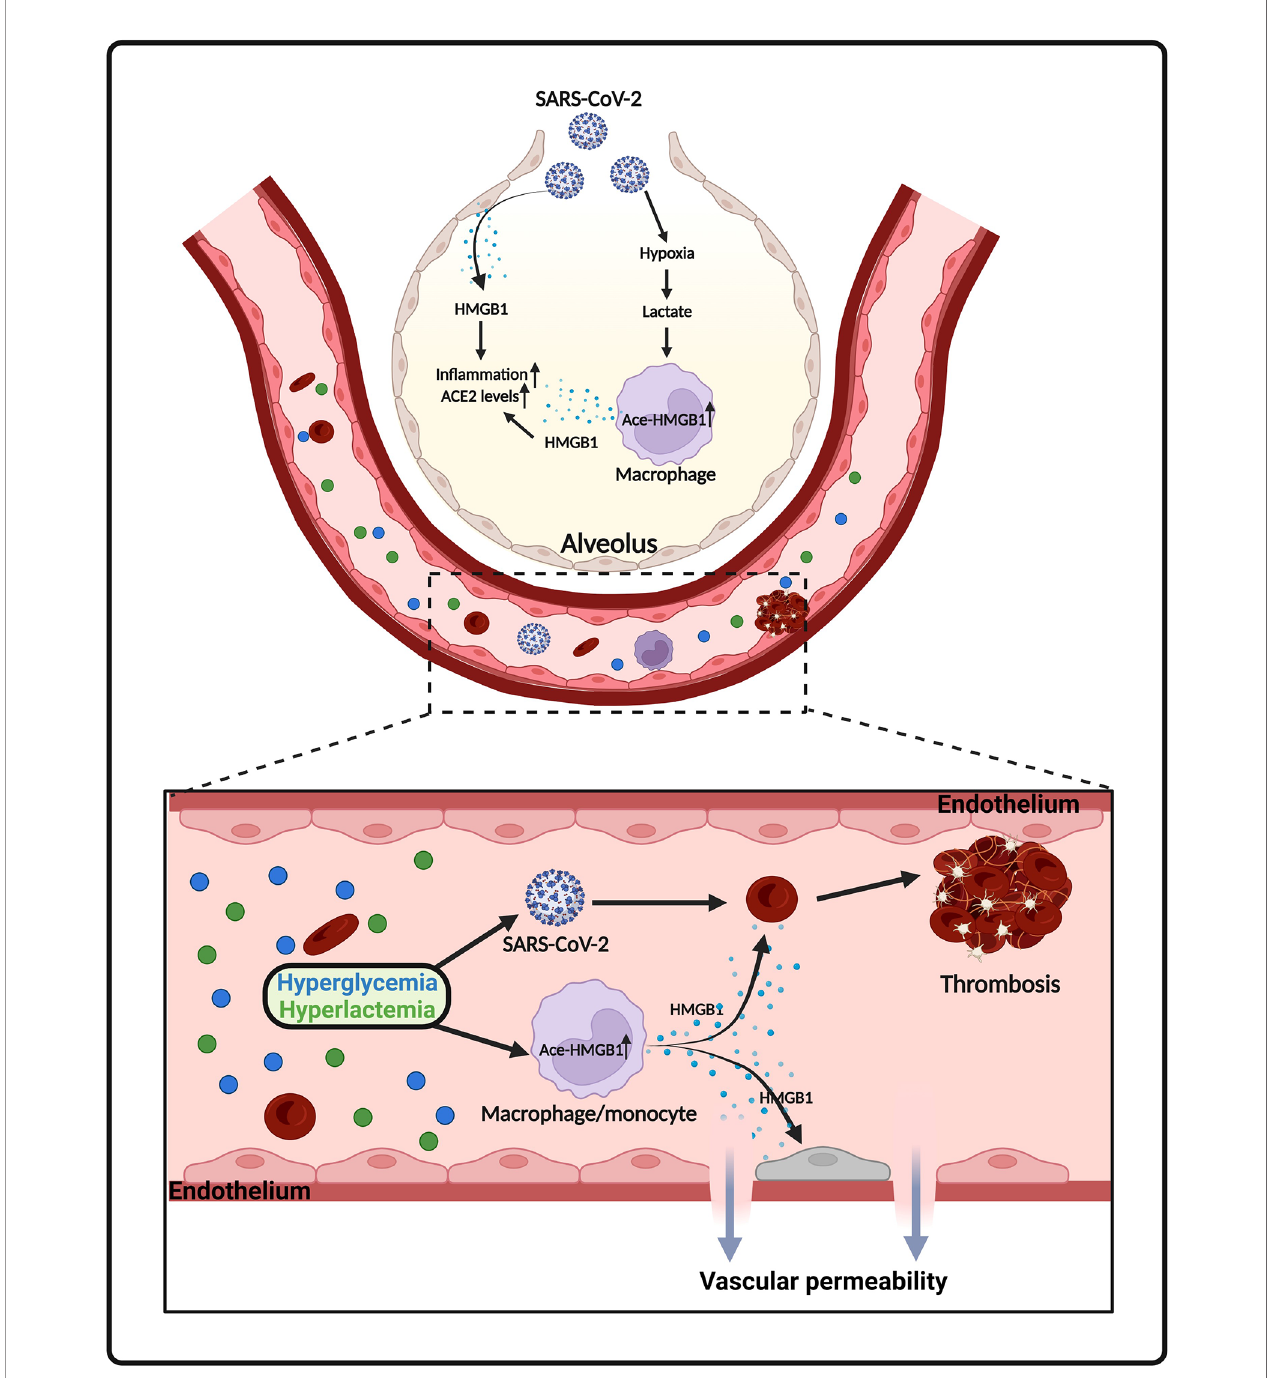
FIGURE 4 | Proposed model of HMGB1 release in SARS-CoV-2 infection. SARS-CoV-2 infection causes death of epithelial cells and release of HMGB1. Lactate, derived from aerobic glycolysis, also promotes HMGB1 acetylation and release from macrophages/monocytes. Elevated levels of HMGB1 further promotes in fl ammatory responses, ACE2 expression, endothelium permeability and thrombosis in